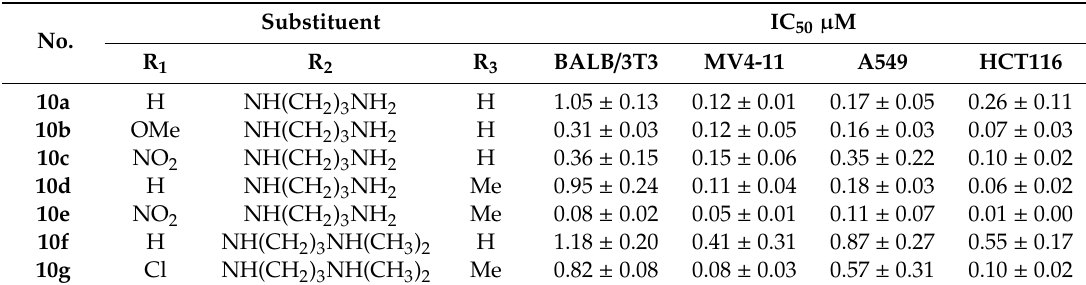
Table 2. Cytotoxic e ff ect of isocryptolepine derivatives